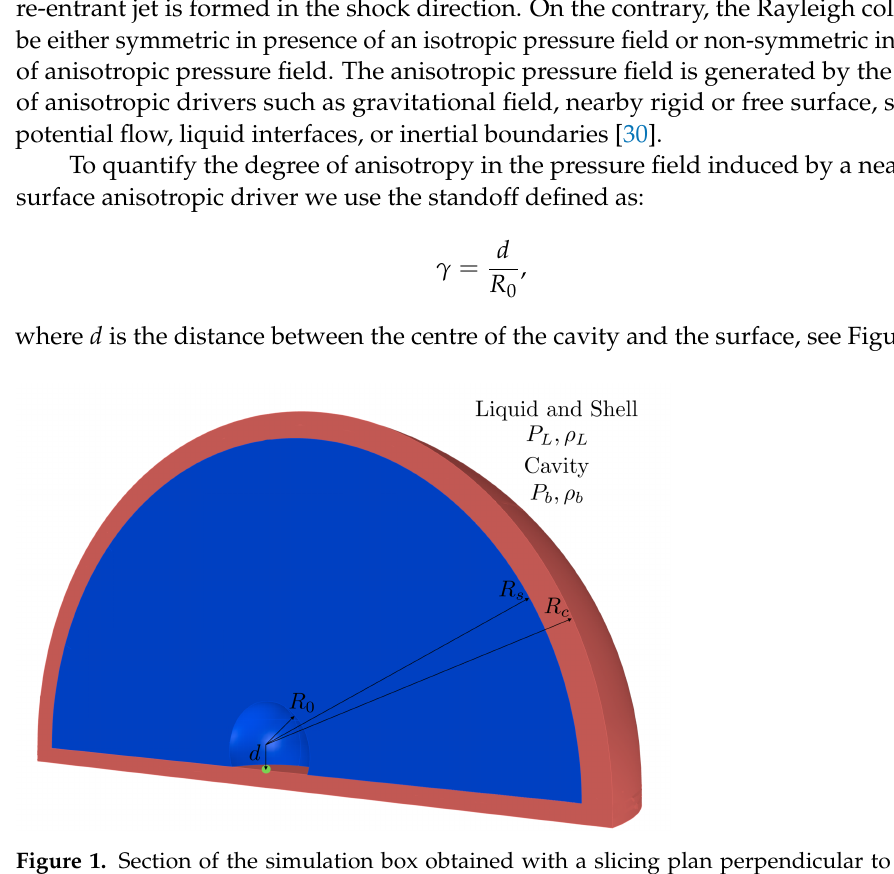
Figure 1. Section of the simulation box obtained with a slicing plan perpendicular to the y -axis and the collapsing cavity at t = 0. The radii dimensions are: R 0 = 1 × 10 − 4 [m], R S = 3 × 10 − 3 [m], and R C =3.1 × 10 − 3 [m]